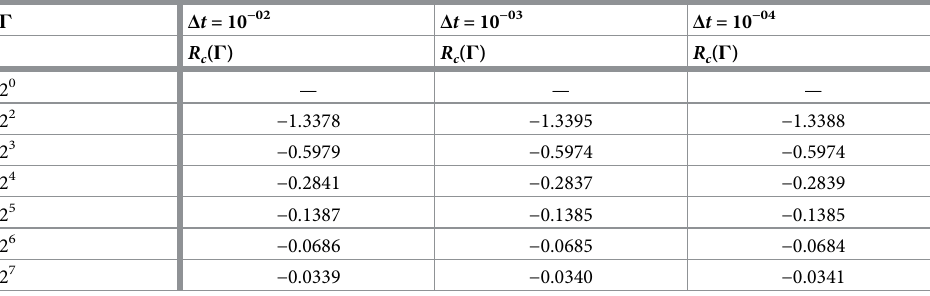
( Γ ) for � k ¼ 0 : 35 , and t = 1 for Test Problem c